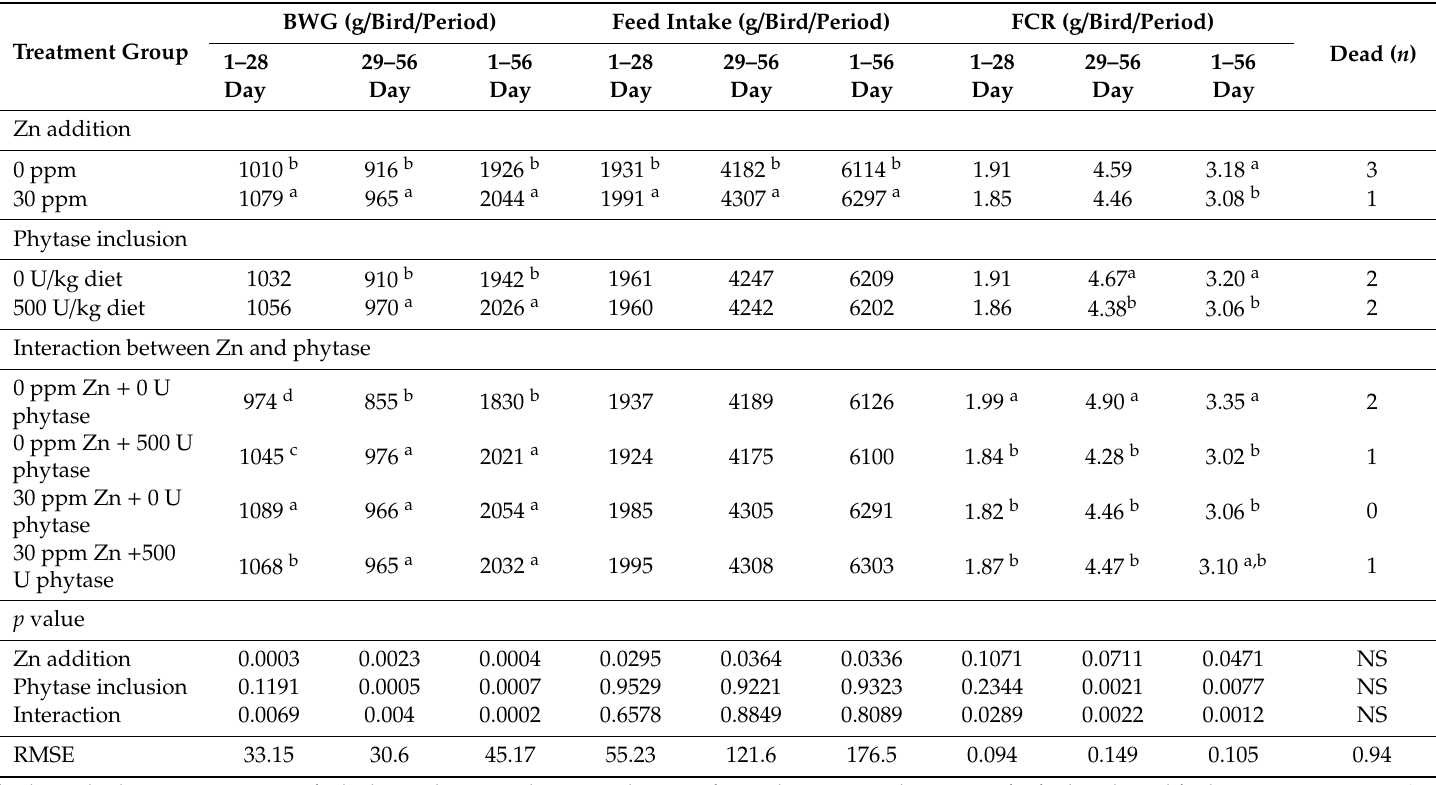
Table 2. E ff ect of zinc supplementation, with and without phytase addition, on body weight gain, feed intake and feed conversion ratio of ducks *.